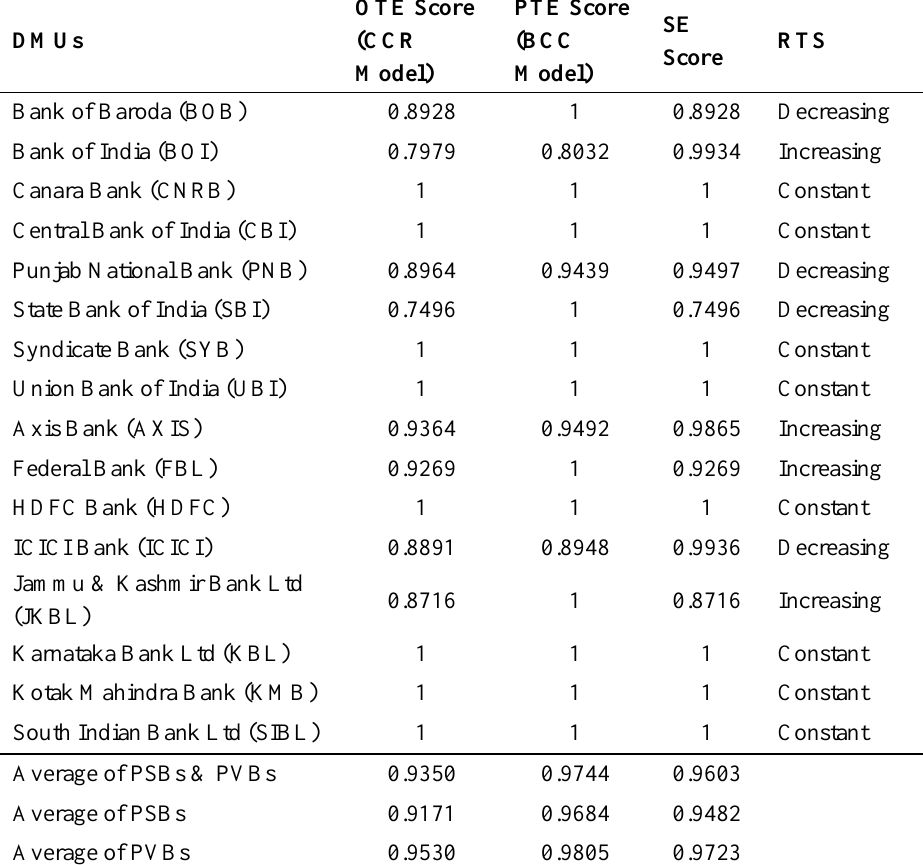
Table 3: Technical Efficiency Scores under BCC and CCR Model